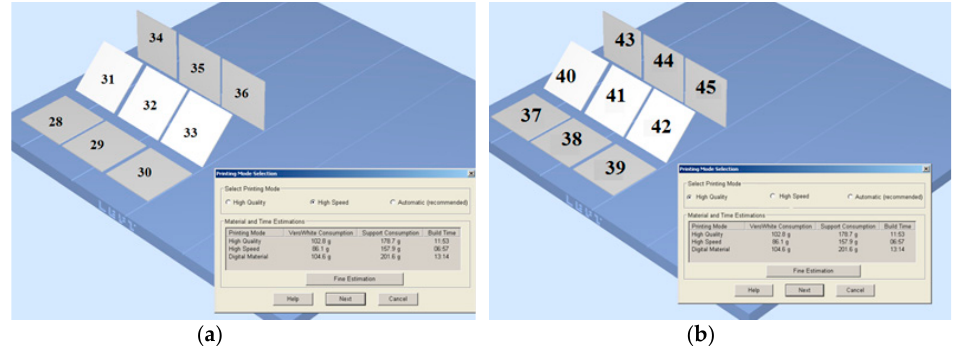
Figure 4. Overview of samples orientation on the build platform prepared for PJM process: ( a ) samples 28–36, ( b ) samples 37–45.